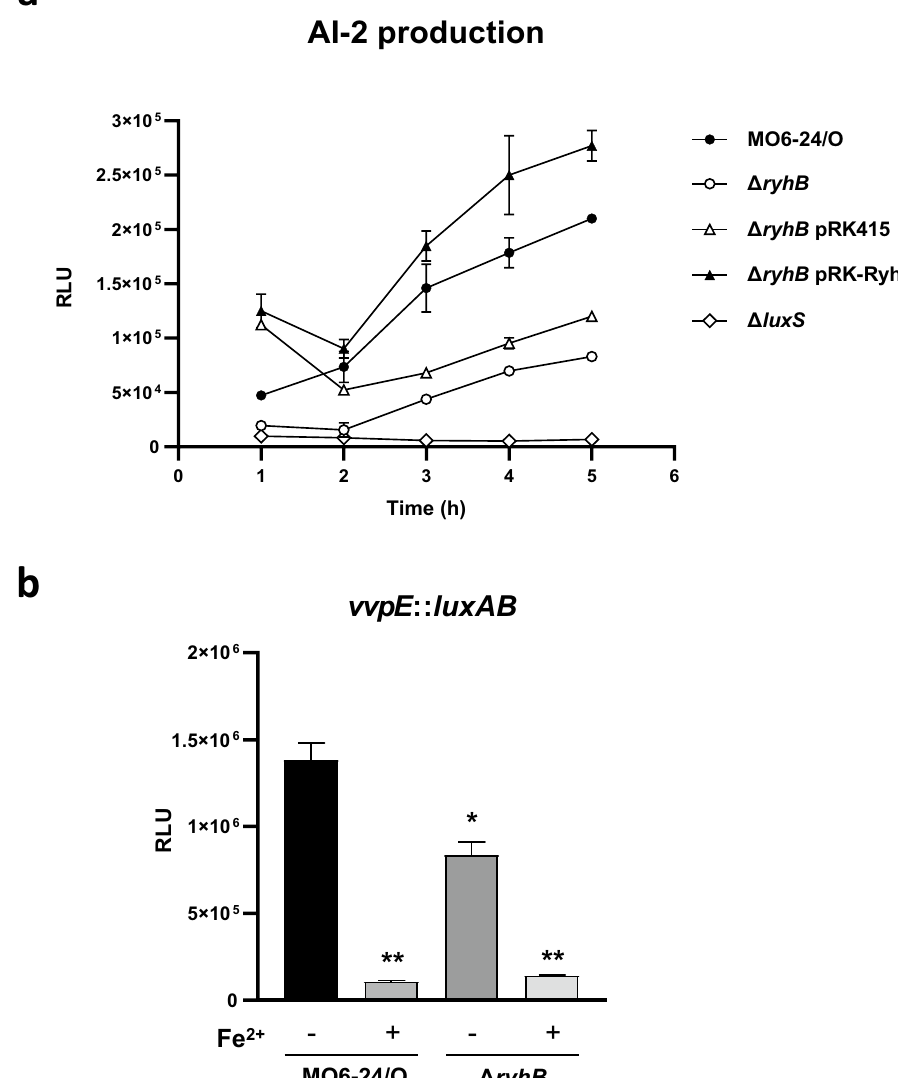
Figure 5. RyhB promotes AI-2 production and vvpE expression. ( a ) Effects of RyhB on AI-2 production were measured using the AI-2 indicator V. harveyi strain BB170. V. vulnificus strains wild type MO6-24/O, Δ ryhB , Δ ryhB with a ryhB clone (Δ ryhB pBBR12- ryhB ), Δ hfq , Δ hfq with a hfq clone (Δ hfq pBBR12- hfq ), and Δ luxS were cultured in AB minimal medium and supernatants were collected to measure AI-2 production. ( b ) Effects of RyhB on the expression of vvpE . vvpE expression was measured using a transcriptional fusion (pHK- vvpE ) in either V. vulnificus wild type or the ΔryhB mutant. V. vulnificus was cultured in LBS medium supplemented with 100 μM of 2, 2 ′ -dipyridyl to A 600 of about 0.1. Samples were collected at late stationary phase (A 600 ≅ 2.5) and both cell density and luminescence were measured. Relative light units (RLU) were normalized to cell density (luminescence/A 600 ). Values are an average of three independent experiments and error bars denote the standard deviations. The p -values for comparison with MO6-24/O (without iron) are indicated (Student’s t -test; *, 0.005 ≤ P < 0.05; **, P <